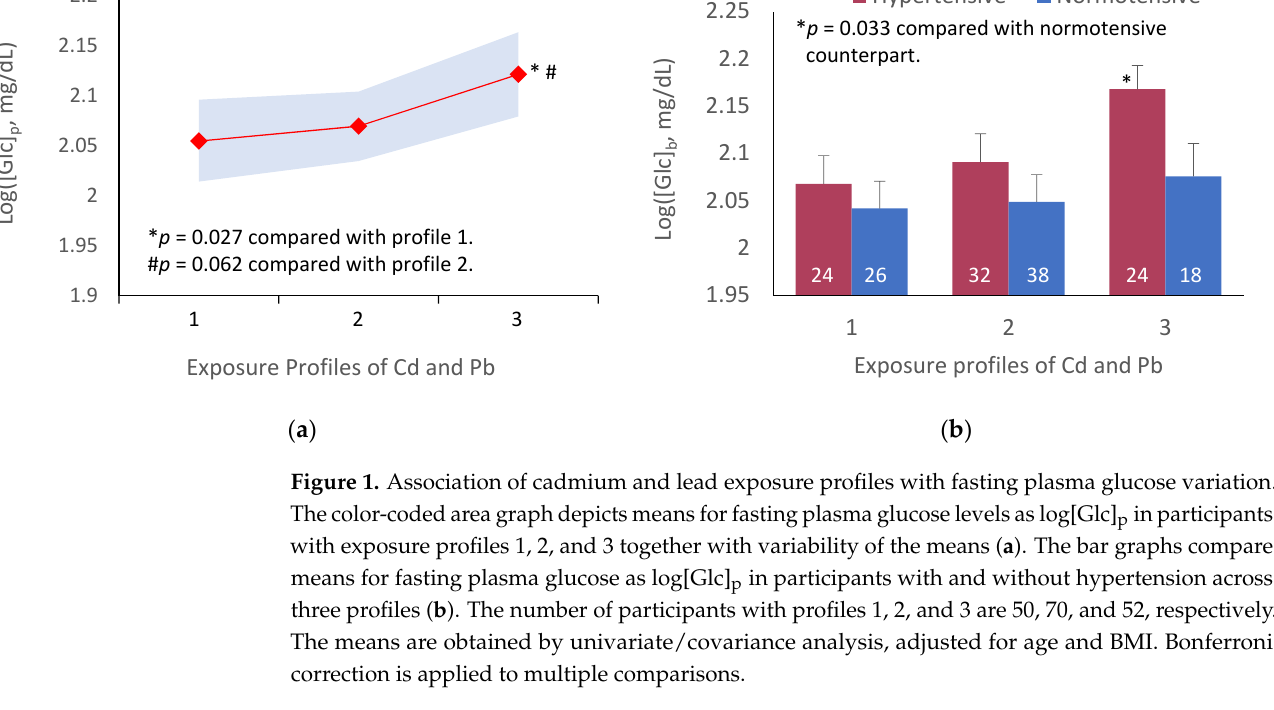
Table 5. Association of the prevalence odds for albuminuria with abnormal fasting plasma glu- cose